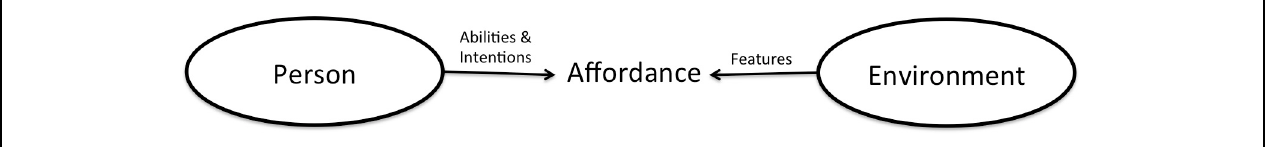
Frontiers in Psychology |